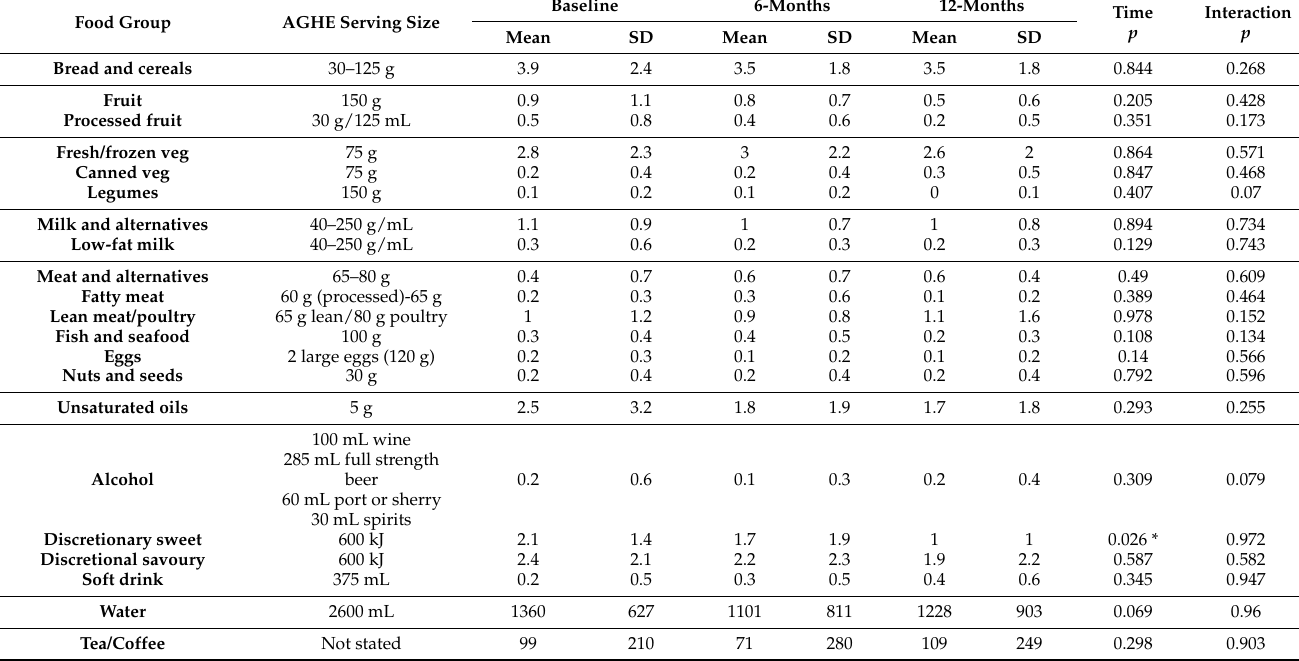
Table 3. Australian Guide to Healthy Eating (AGHE) food group analyses from the diet diaries